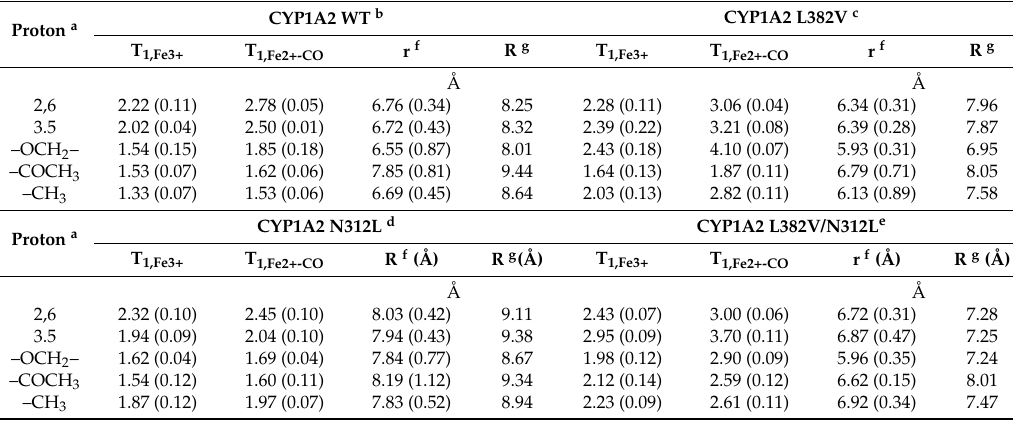
Figure 4. Nuclear magnetic resonance (NMR) spectrum of the protons of phenacetin obtained under conditions used for T 1 measurements. The numbering scheme used is the same as shown in Figure 1. Table 3. T 1 relaxation rate-estimated distances of phenacetin protons from the heme iron of CYP1A2 WT and the mutants. Standard errors (SEs) for measurements are shown in parentheses. Errors in the T 1 values were those reported by the fitting routine. Errors in the reported distances (r) were determined by propagation of error from the T 1 calculation. Generally, the error is